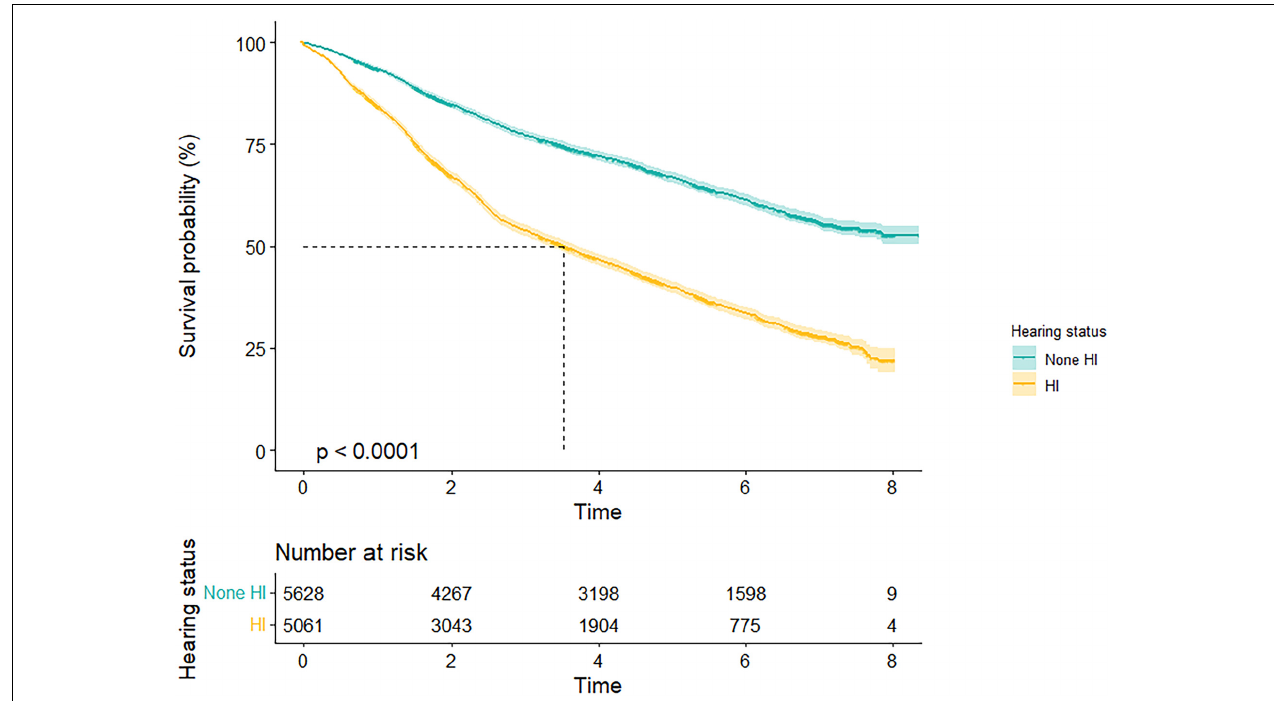
FIGURE 1 | Survival probability by different hearing states. Kaplan–Meier survival curves illustrated a conspicuous probability of survival relationship between hearing status and all-cause mortality for total population ( p < 0.001). HI, hearing